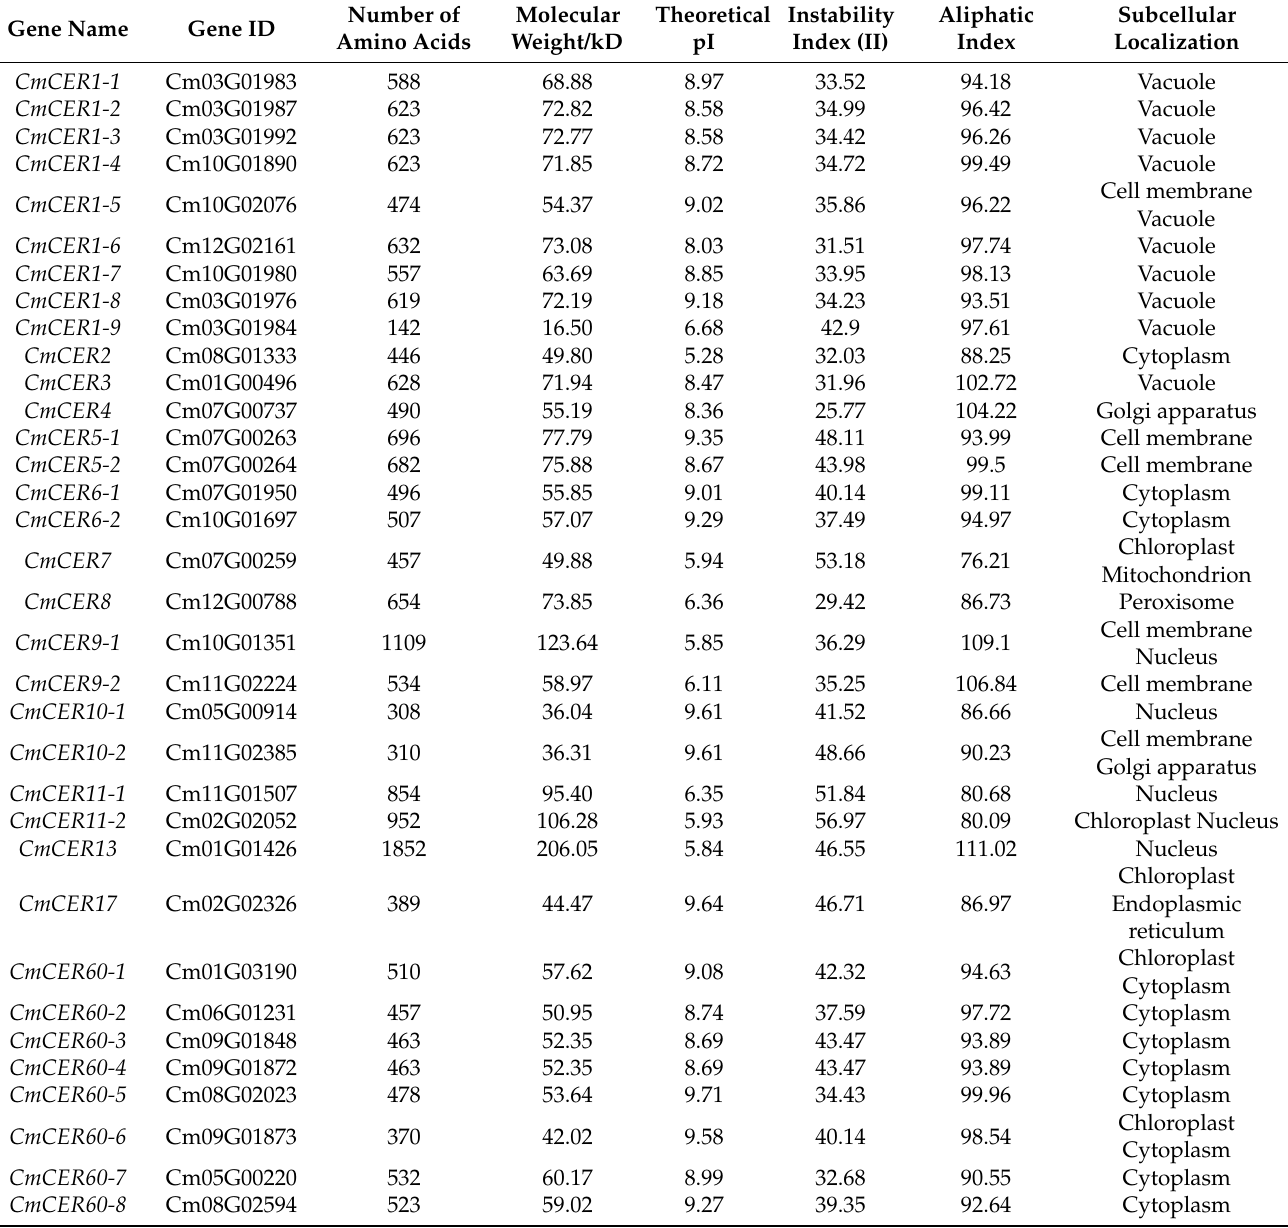
Table 1. Physicochemical properties of CER genes identified in C. mollissima